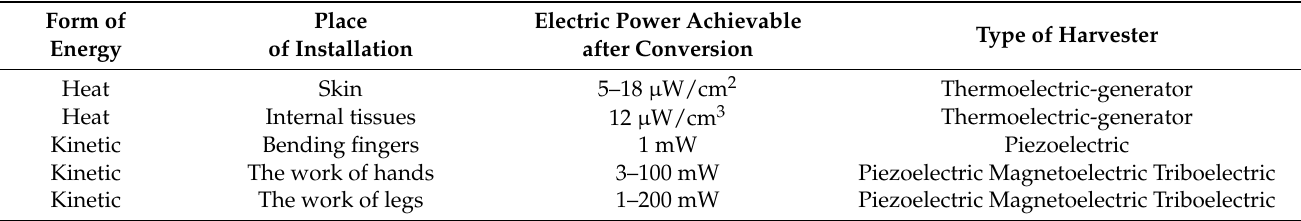
Table 3. Harvesting energy from the human